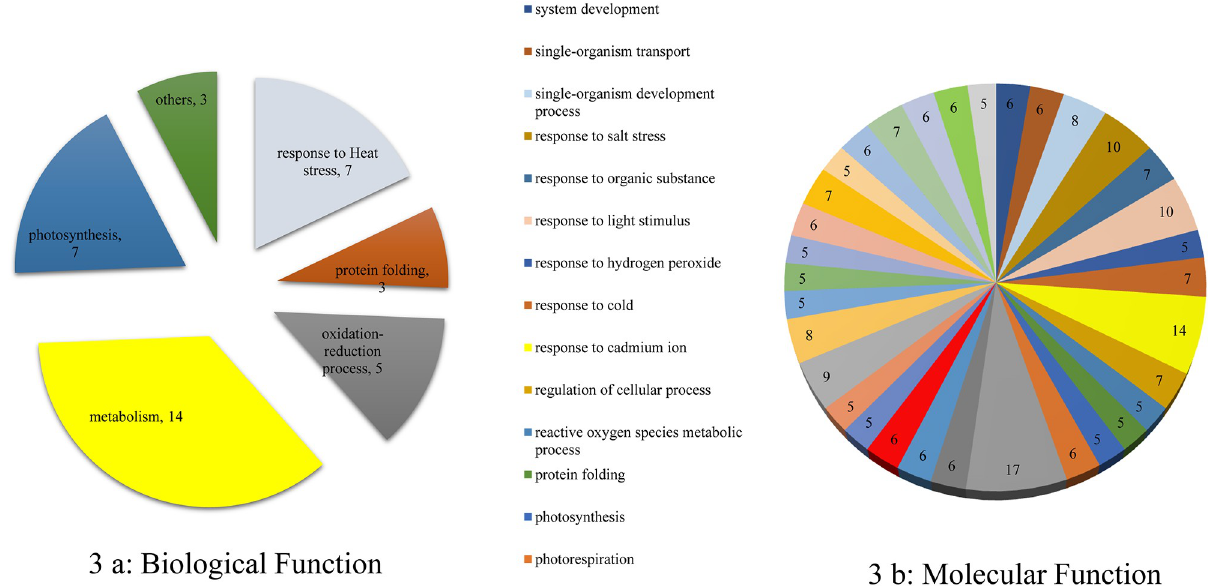
Fig 3. Gene ontology of stress responsive proteins: (a) Biological, (b) Molecular functions.